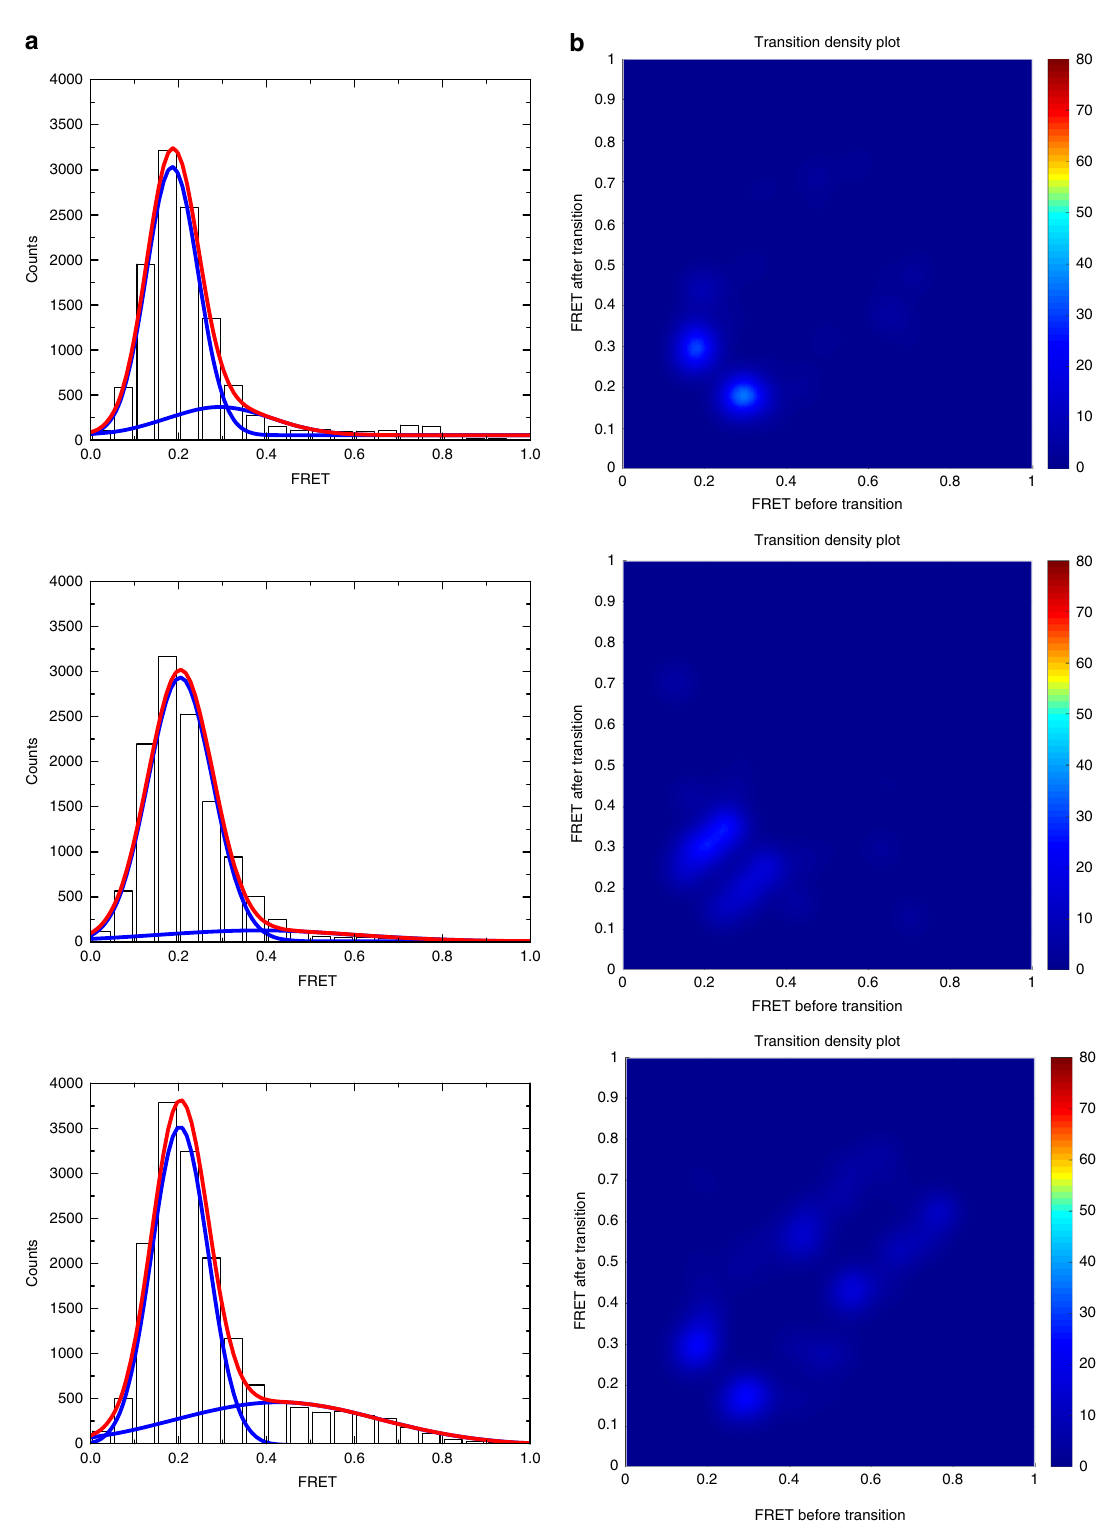
Fig. 5 Dynamics in the apo and substrate bound of the proton-relay mutant of CmeB. a FRET ef fi ciency population histograms of CmeB (in the absence of Tdc ( n = 40 traces), top panel ; in the presence of 1 μ M Tdc ( n = 37 traces), middle panel ; in the presence of 10 μ M Tdc ( n = 47 traces), bottom panel ). b Transition density plots for the CmeB ef fl ux pump (in the absence of Tdc, top panel ; in the presence of 1 μ M Tdc, middle panel ; in the presence of 10 μ M Tdc, bottom panel